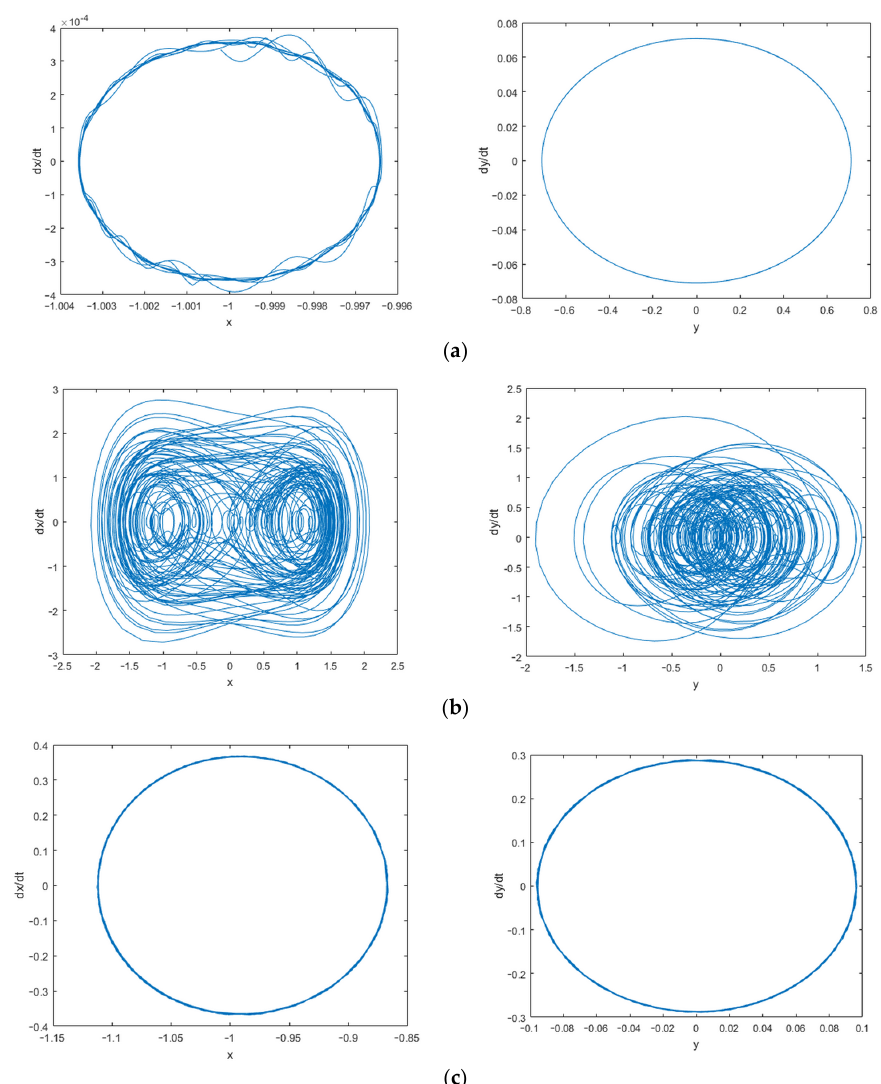
Figure 7. Phase diagrams of the absorber (on the left side) and the main system (on the right side) at different excitation frequencies. ( a ) p = 0.7, ω = 0.1; ( b ) p = 0.7, ω = 2; ( c ) p = 0.7, ω = 3.